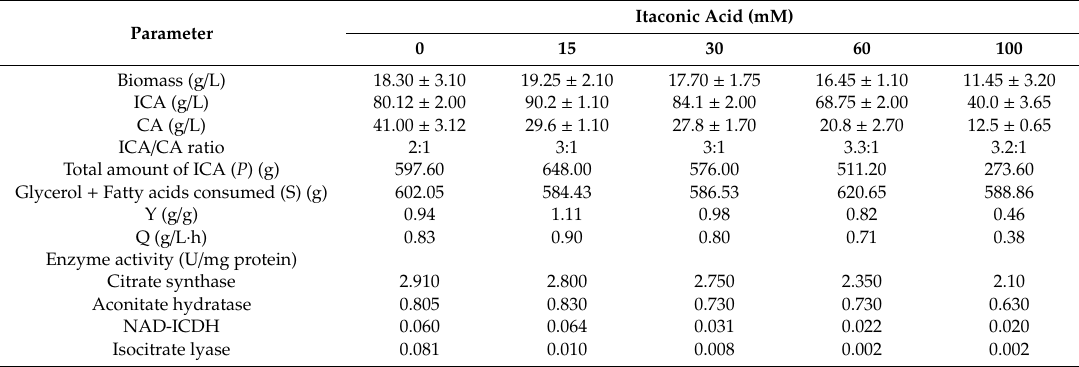
Table 5. E ff ect of itaconic acid on growth and ICA production by Y. lipolytica VKM Y-2373.